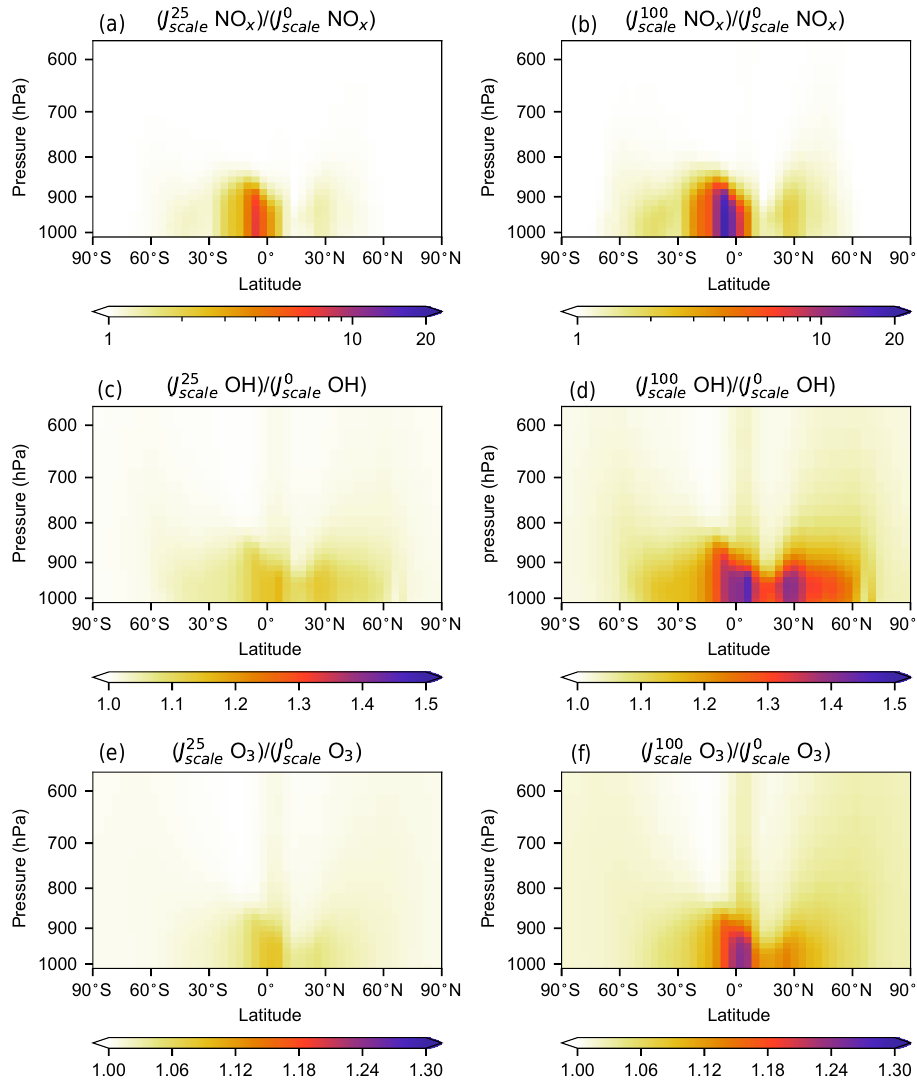
Figure 10. Latitude–altitude plot of average 2014–2015 NO x (a, b) , OH (c, d) , and O 3 (e, f) for the J 25 b , d , f , respectively) relative to corresponding fields for the J 0